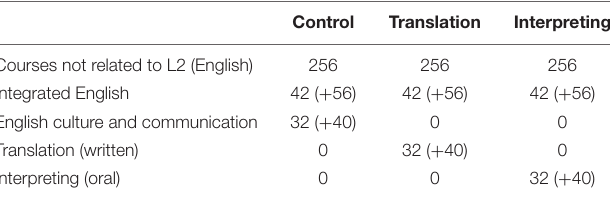
TABLE 1 | Class hours of courses for the three participant groups (control, translation and interpreting) together with practice after class (in brackets) during the experimental